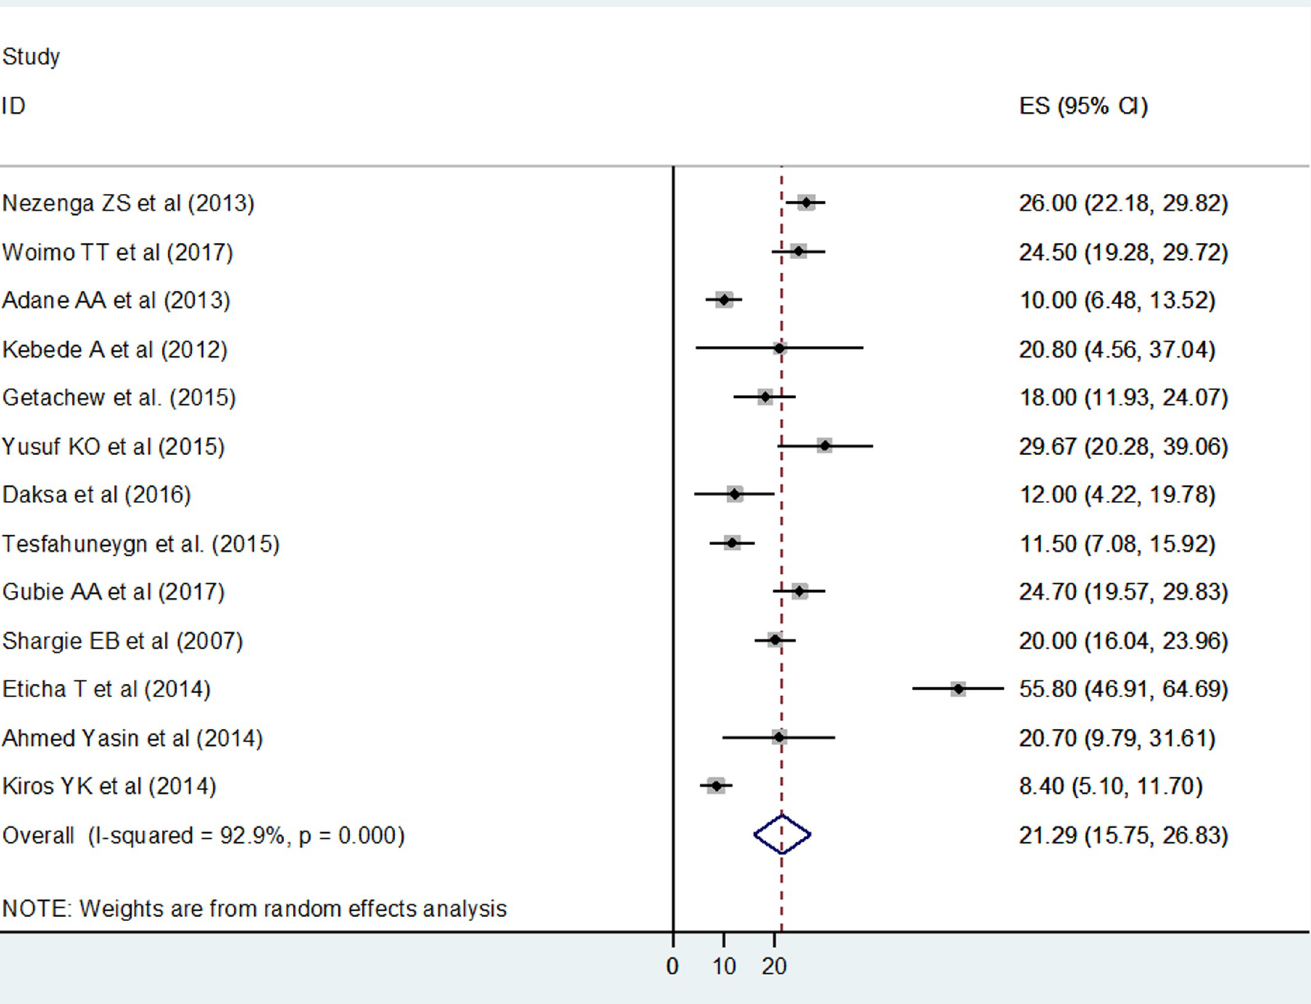
Fig 2. Forest plot depicting the pooled prevalence of non-adherence to anti TB medication in